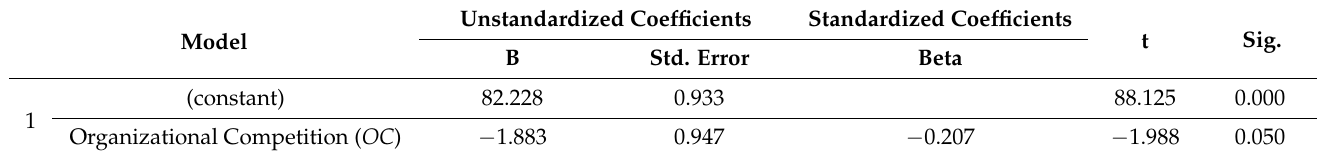
Table 13. Results of regression between OC and the effectiveness of ITG a .